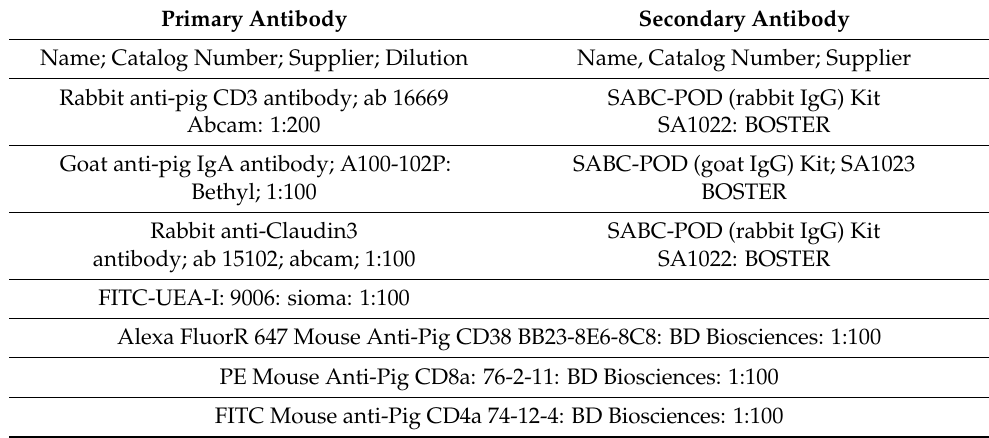
Table 1. Information of